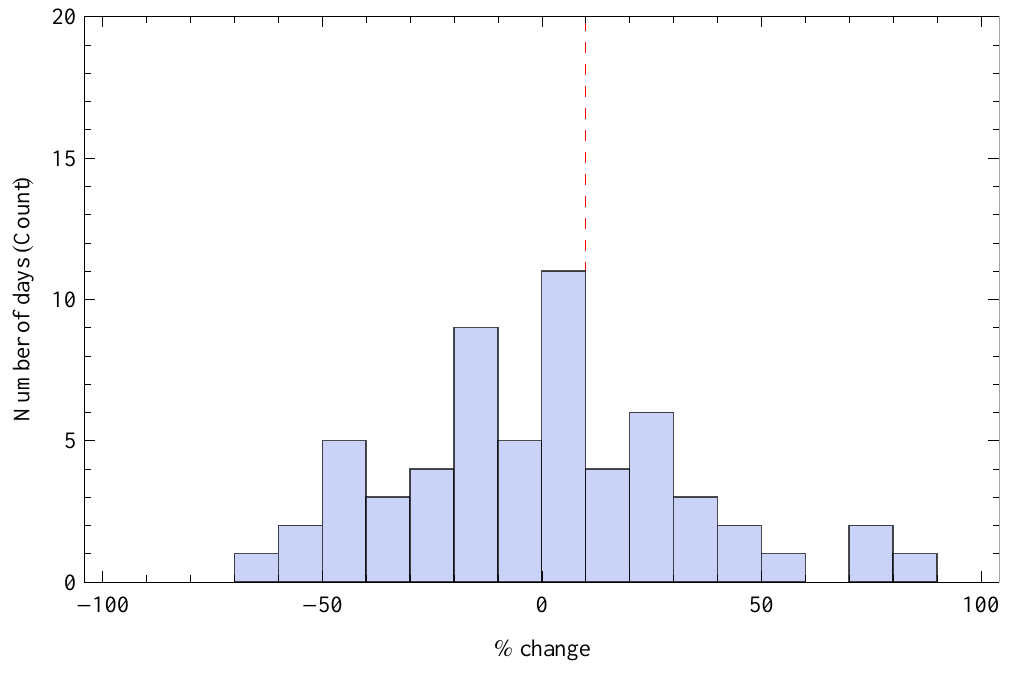
Figure 2. INTC histogram of trading volume daily change, starting from 13 October 2009 over 60 trading days. The dashed vertical line is the 10% threshold. ART ( ∆ V60 , 10% ) =